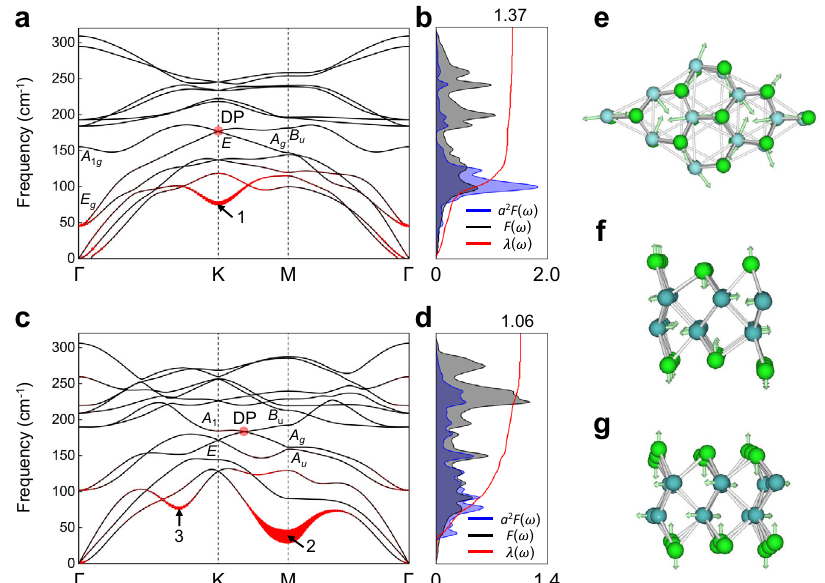
Fig. 2 Phonon properties and EPC. a Phonon dispersion of monolayer ZrCl and b its Eliashberg function a 2 F ( ω ), phonon DOS F ( ω ) and accumulated EPC coef fi cient λ ( ω ). c Phonon dispersion of monolayer MoCl and d its a 2 F ( ω ), F ( ω ) and λ ( ω ). In a and c , the red weighted dots display momentum-mode resolved λ q v by magnitude. The Dirac points (DPs) and acoustic soft modes at point 1, 2 and 3 are also marked. e Schematic of the vibration mode of monolayer ZrCl at point 1 with frequency 75.8 cm − 1 , where Zr atoms in the top (bottom) sub-monolayer vibrate circularly left-handed (right-handed), as indicated by the arrows. Schematics of the vibration modes of monolayer MoCl f at point 2 with frequency 37.1 cm − 1 and g at point 3 (along Γ – K path) with frequency 77.1 cm − 1